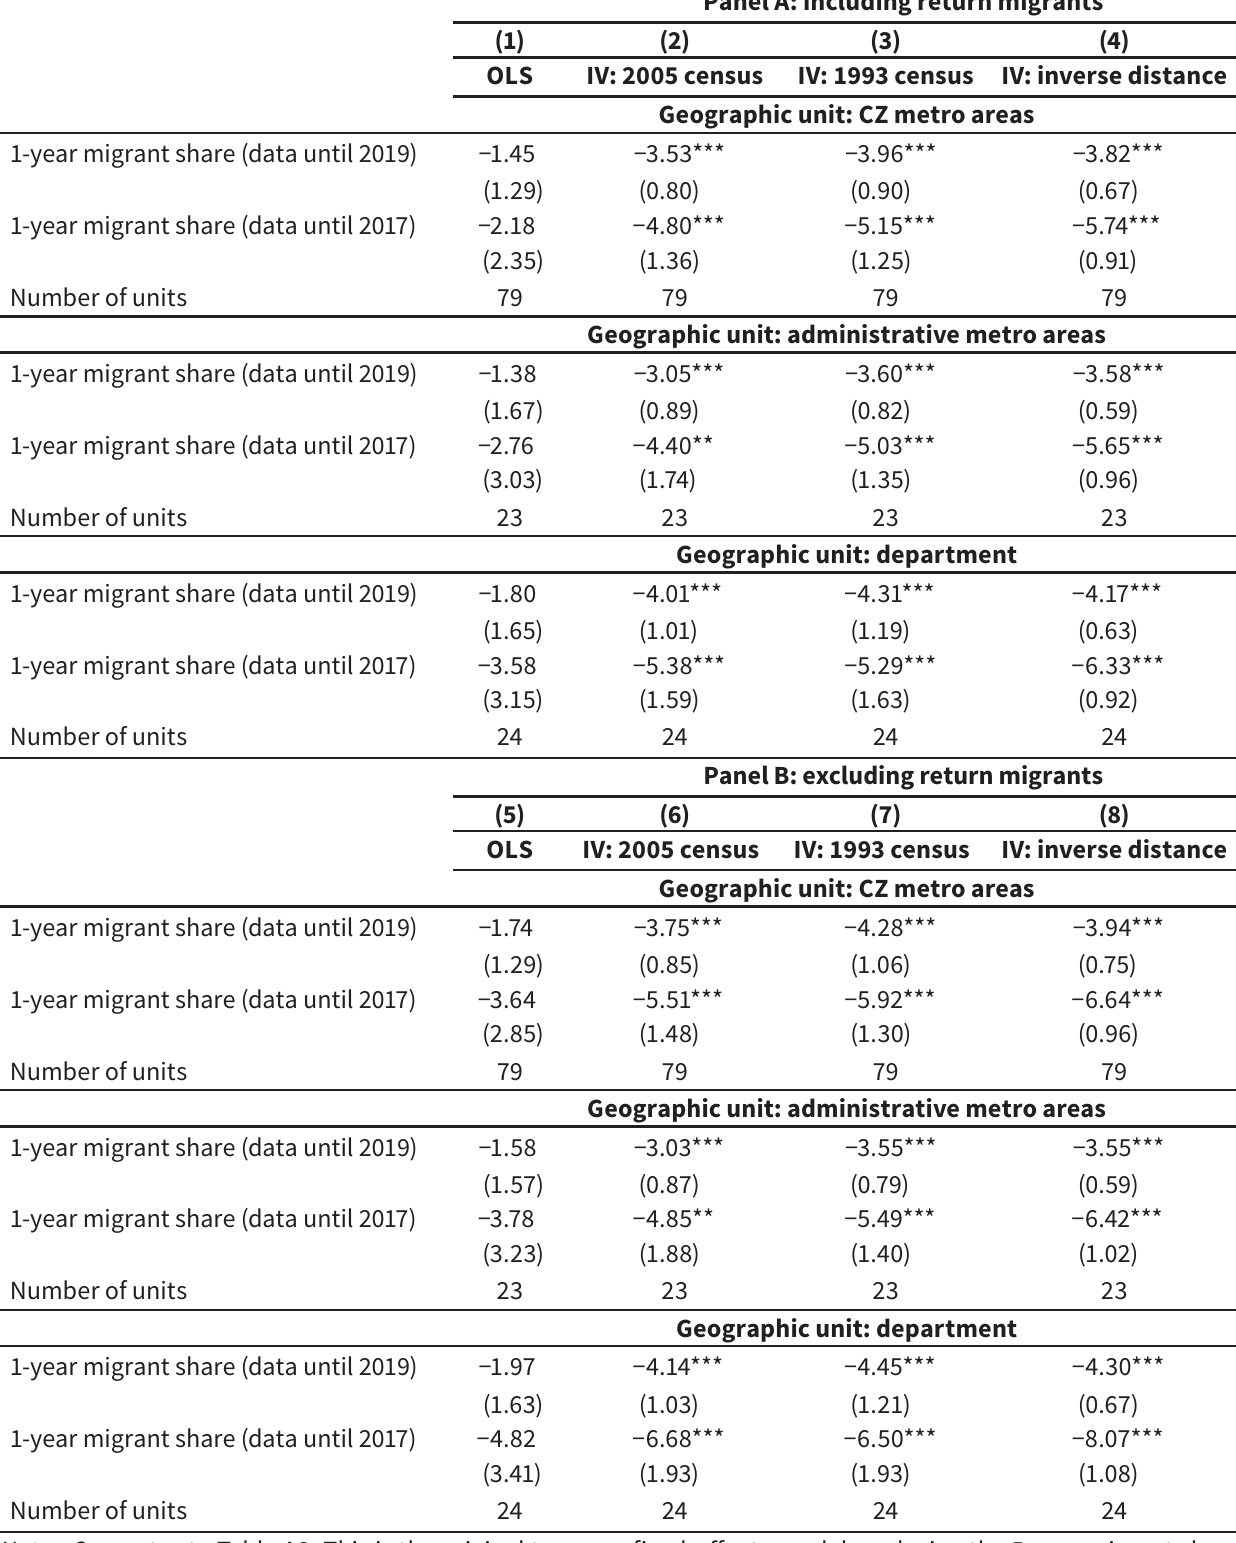
Wage estimate sensitivity: 1-year migration